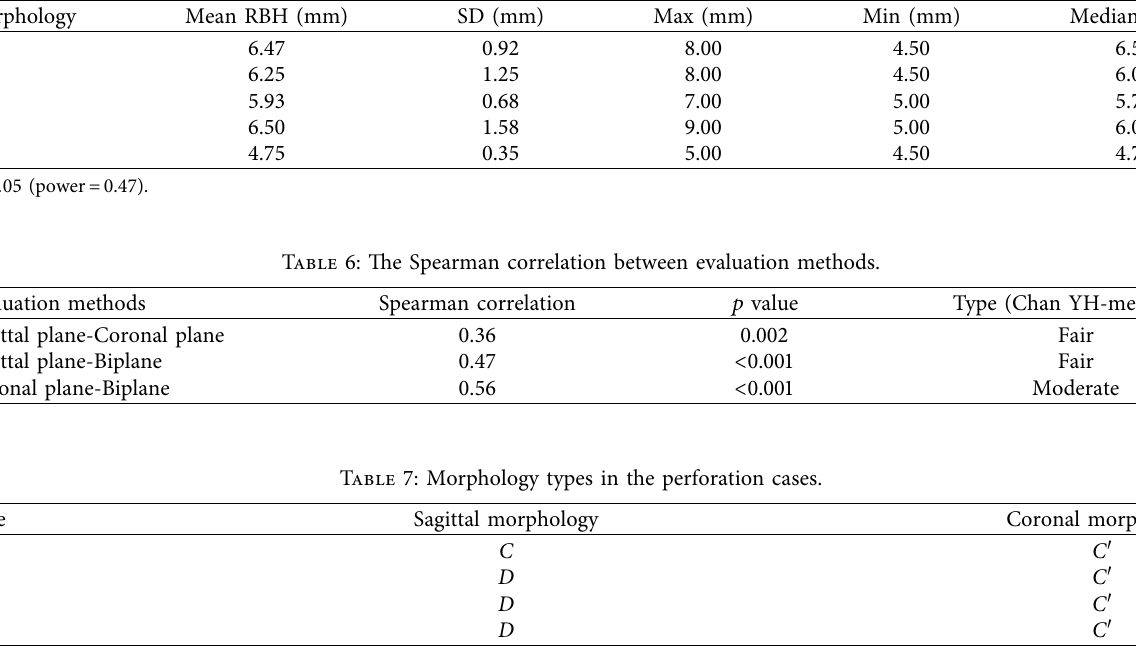
Table 5: The RBH values were compared between different morphological classifications based on the biplanes. Morphology